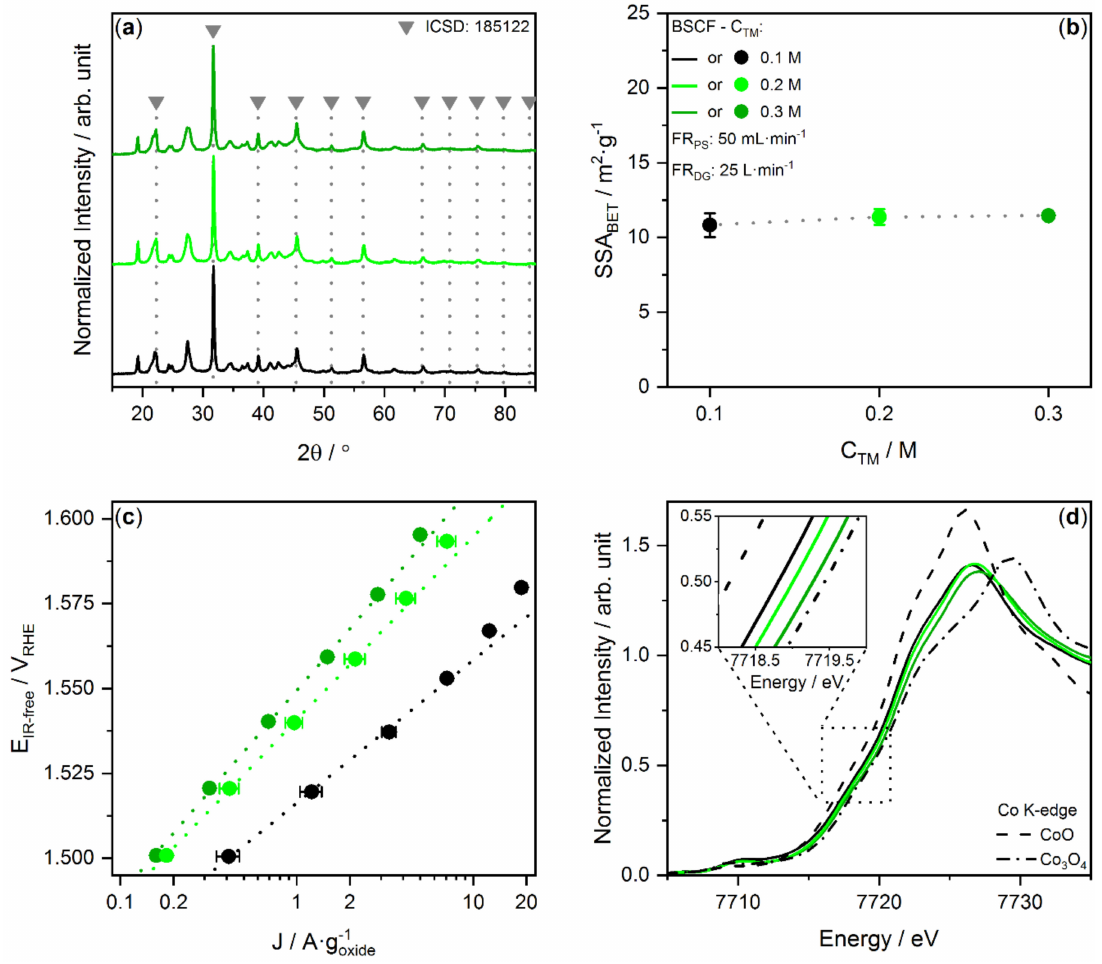
Figure 2. Summary of the influence of the total metal concentration (C TM ) in the range of 0.1 ( — or • ), 0.2 ( — or • ) and 0.3 M ( — or • ) on flame spray synthesized Ba 0.5 Sr 0.5 Co 0.8 Fe 0.2 O 3- δ (BSCF): ( a ) Powder X-ray di ff raction (XRD) patterns ( (cid:72) ICSD reference of BSCF: 185122); ( b ) Specific surface areas calculated with the Brunauer-Emmett-Teller equation (SSA BET ); ( c ) Tafel plot of the oxygen evolution reaction (OER) activities with linear fit (dotted line); ( d ) Co K-edge X-ray absorption near edge spectroscopy (XANES) spectra of the as-synthesized BSCF batches (standards: CoO ( – – ) and Co 3 O 4 ( – • – )). For all cases: Flow rate of the precursor solution (FR PS ) = 50 mL · min − 1 and dispersion gas (FR DG ) = 25 L · min − 1